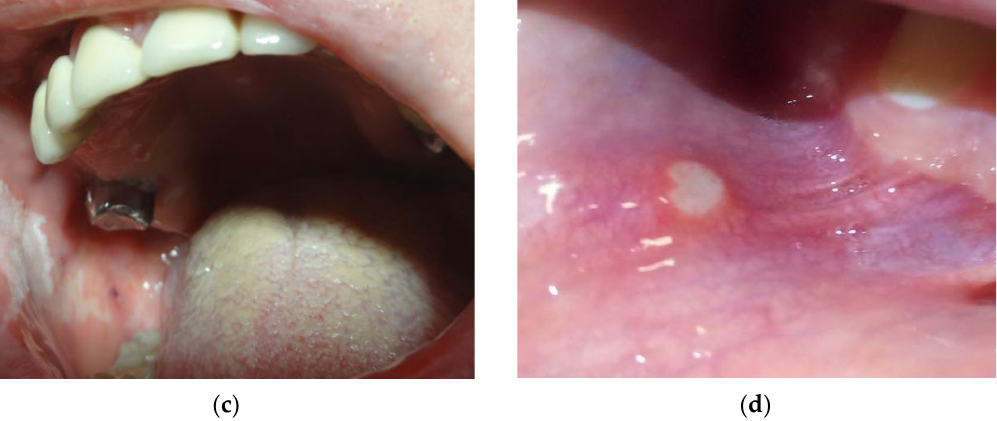
Figure 3. The most common oral lesions that may be associated with dental alloys: ( a )—oral lichen planus; ( b )—oral mucosa pigmentation; ( c )—oral leukoplakia; ( d )—recurrent aphthous stomatitis.